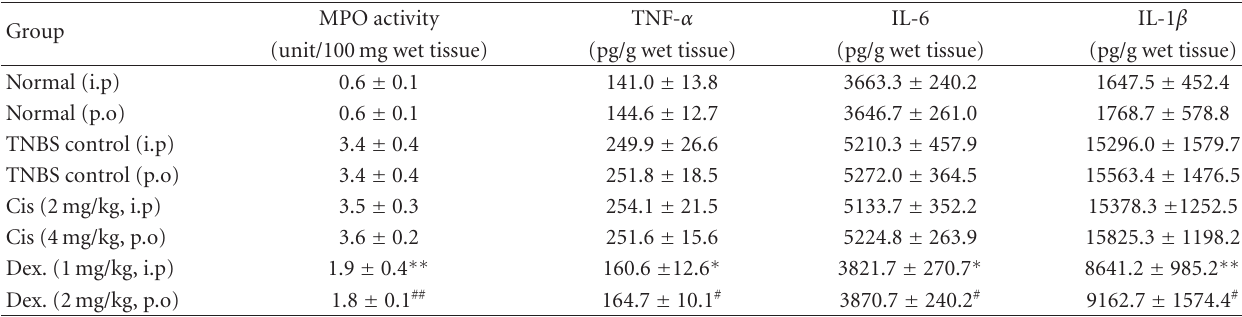
(pg/g wet tissue)